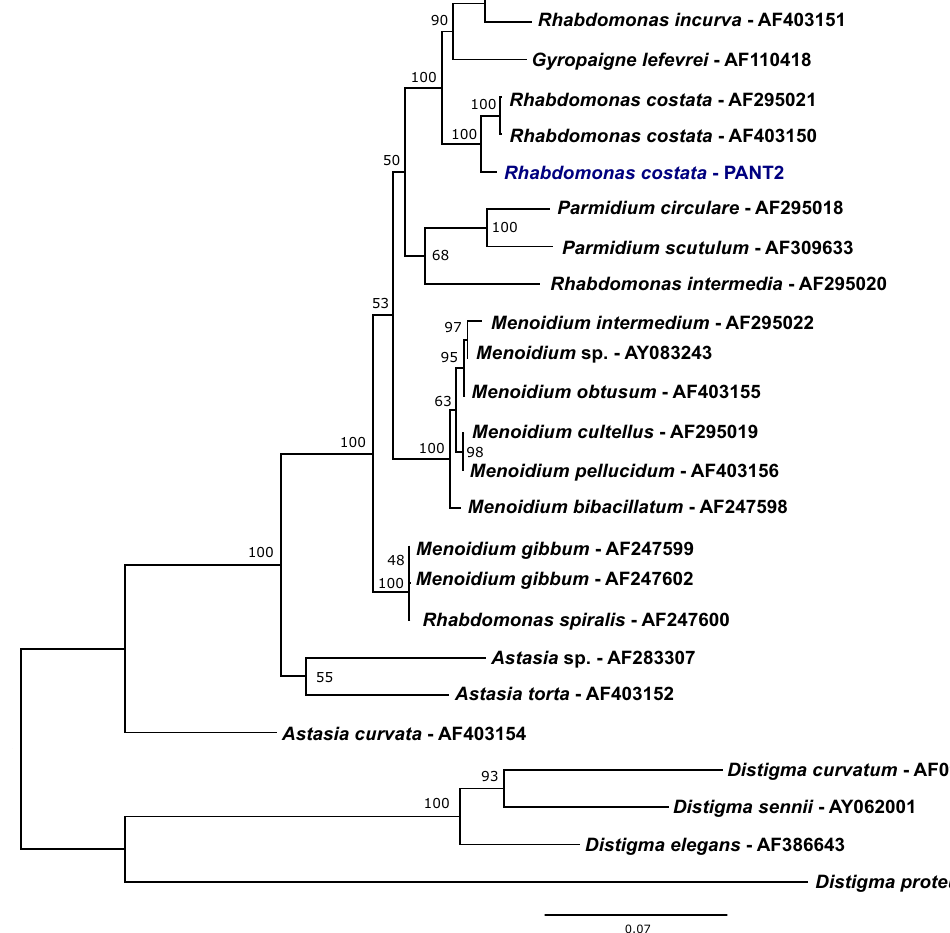
Figure 1. Phylogenetic tree of euglenids based on the 18S rRNA gene. The tree was constructed in IQ-TREE using the TIM2e + G4 model selected by Bayesian information criterion from a trimmed alignment containing 1569 nucleotide positions. The values at the nodes represent ultrafast bootstraps from 1000 repetitions, where above 50. The strain analysed in this study is shown in blue. The tree was rooted by the genus Distigma . The figure was created in FigTree v